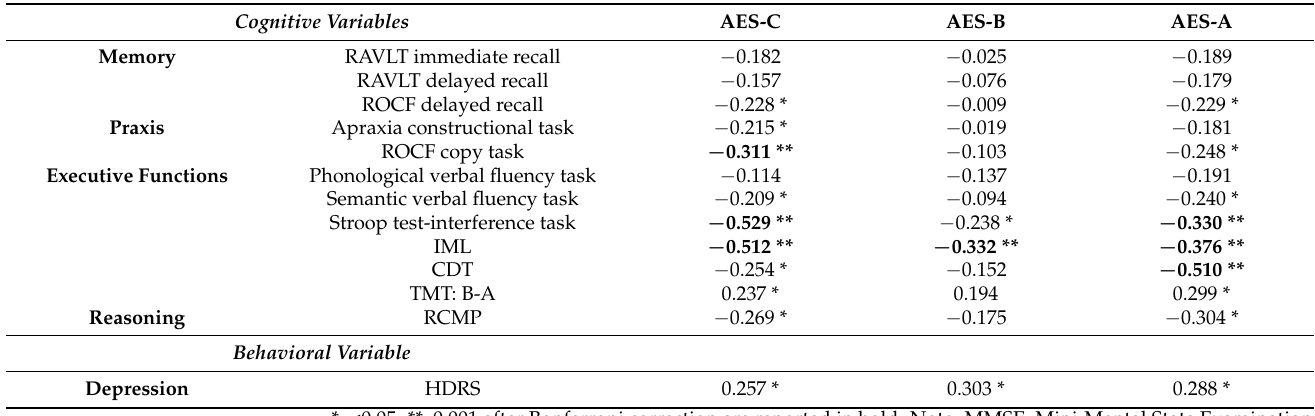
Table 2. Correlations between AES sub-domains and cognitive functions in participants with Multi- ple